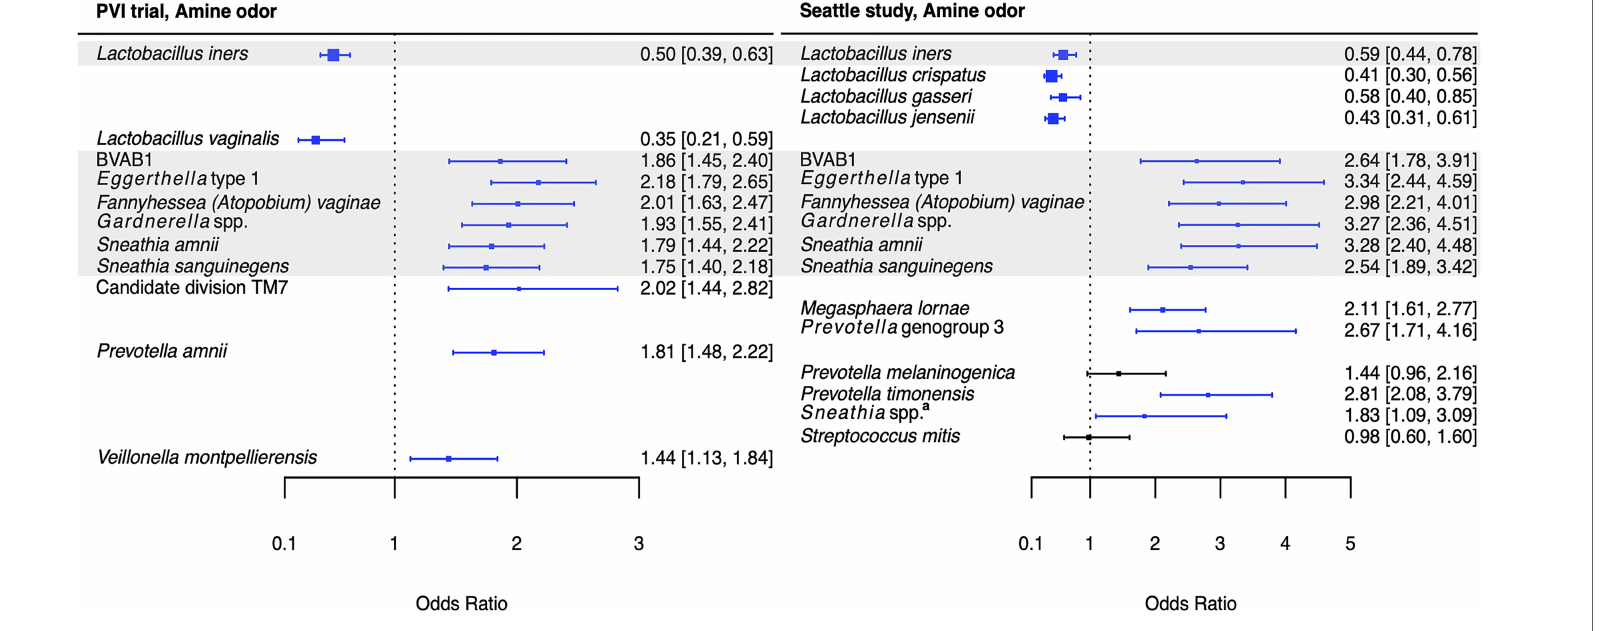
FIGURE 2 | Logistic regression modeling results for the association between vaginal bacteria and amine odor. Gray shading indicates taxa that were modeled in both study populations. Blue box and whiskers indicate associations that were signi fi cant following Benjamini-Hochberg multiple comparisons adjustment (5% false discovery rate), and black box and whiskers indicate associations that were not signi fi cant following multiple comparisons adjustment. All models were univariable logistic regression models with the Amsel criterion as the outcome and bacterial relative abundance as the exposure. Bacterial relative abundances were modeled as tertiles with the reference level being no detection (four-level ordinal variables with levels: no detection, tertile 1, tertile 2, tertile 3). Generalized estimating equations with an independent correlation structure were used for PVI trial models, and no variables were lagged in PVI models. a Sneathia spp. includes those not classi fi ed at the species level as S . amnii or S . sanguinegens , but closely related to these two species. Sequences are not suf fi ciently different at the V3-V4 region of the 16S rRNA gene to classify at the species level, hence classi fi ed at the genus level. PVI, Preventing Vaginal Infections; OR, odds ratio; CI, con fi dence interval; BVAB, bacterial vaginosis associated